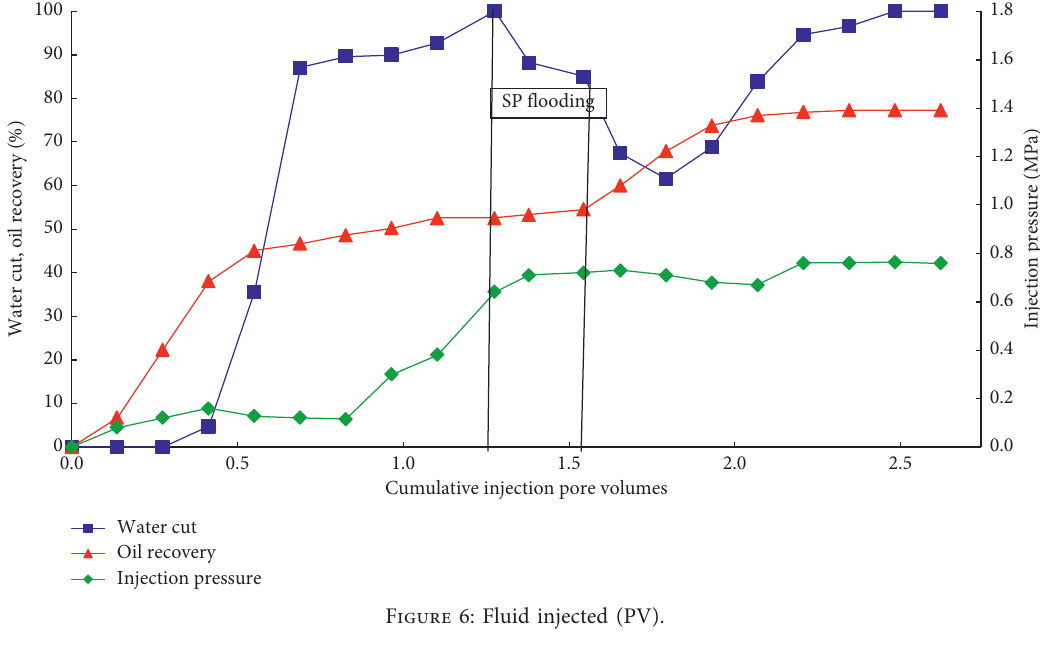
Figure 6: Fluid injected